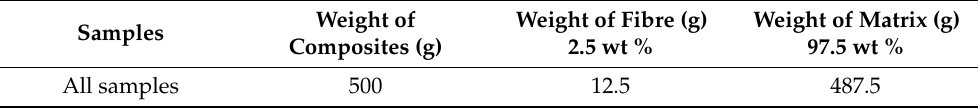
Table 3. Composition of